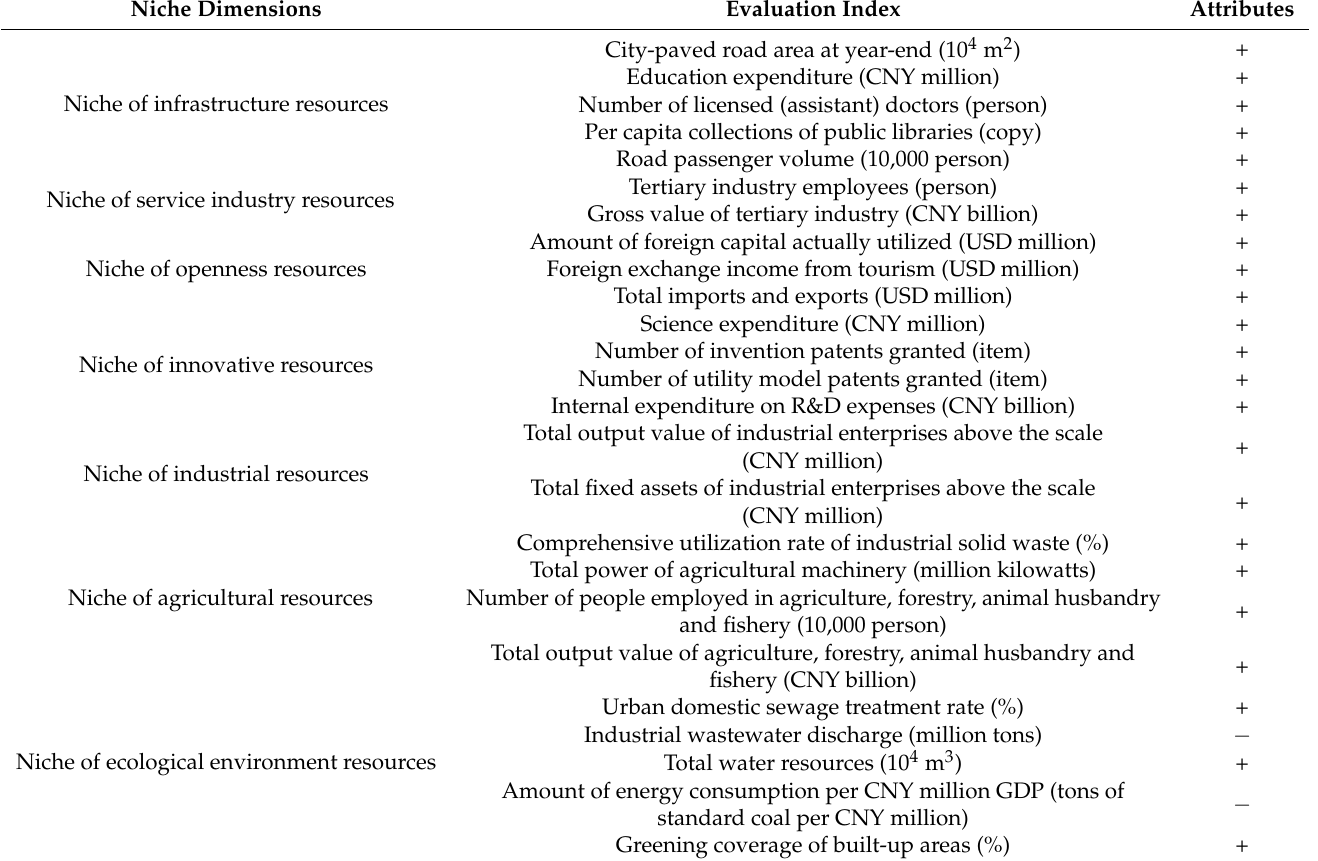
Table 1. Evaluation index system of niche suitability of the high-quality development of YRB